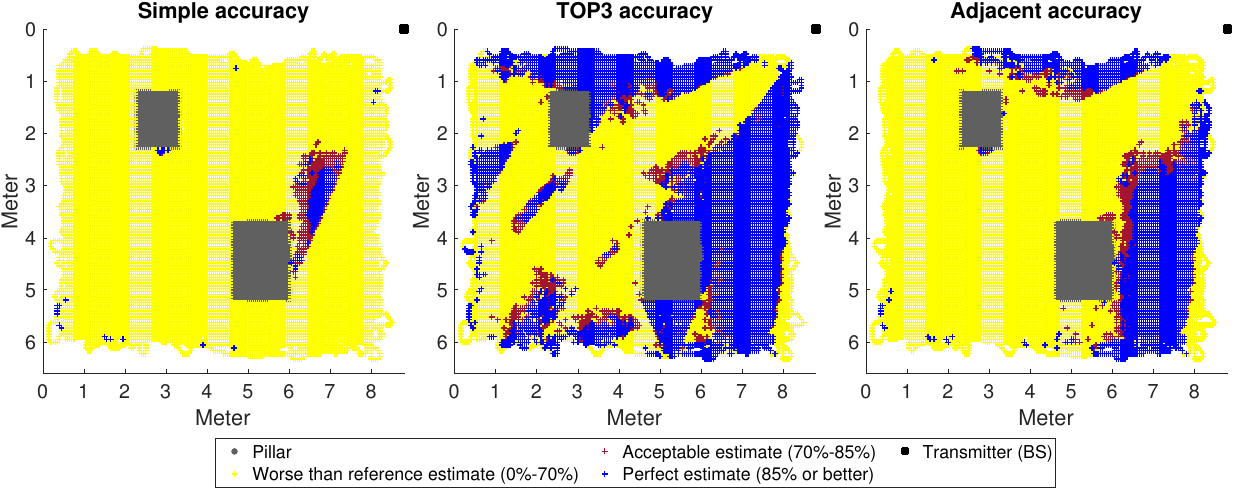
Figure 6. A movement of 5,000,000 steps in Room A2; the accuracy interpreted according to the metrics is presented. The areas marked in white were not visited during the